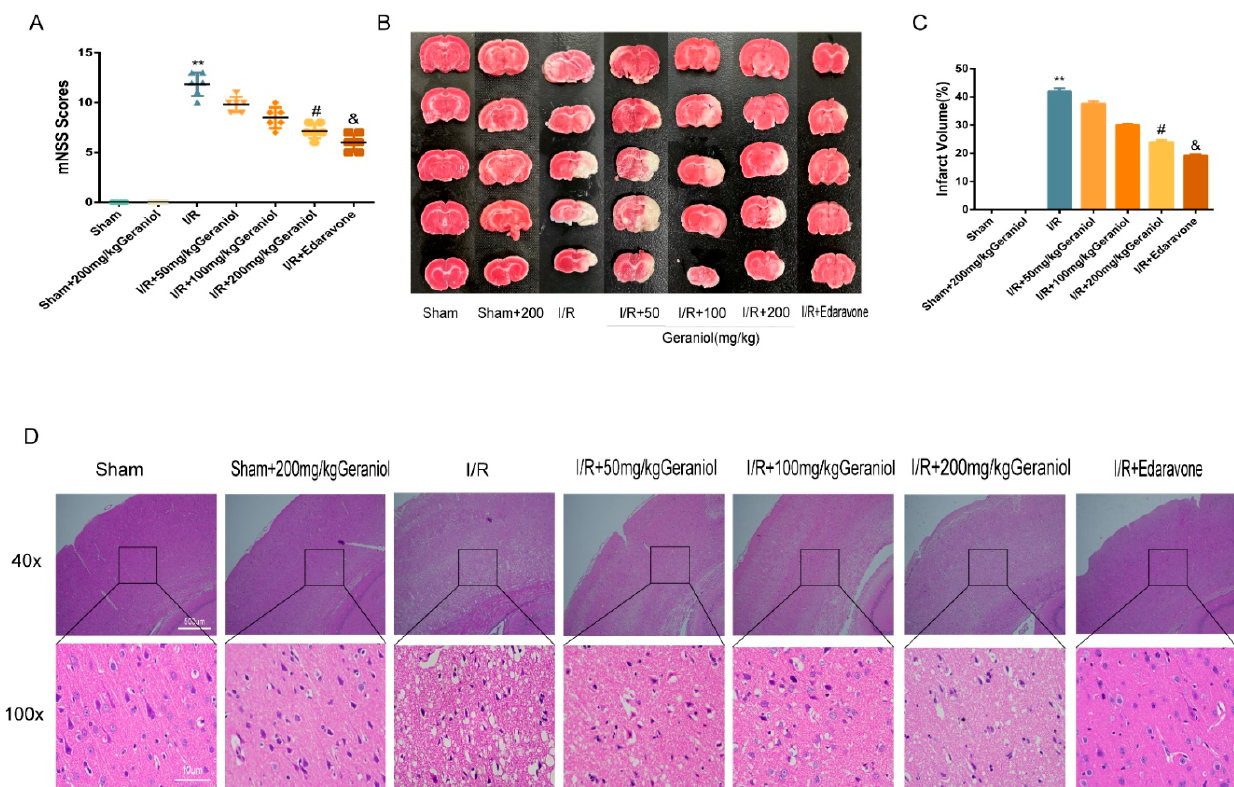
Figure 1. Protective effect of geraniol against ischemia–reperfusion (I/R)-induced brain damage. ( A ) Modified neuronal severity score (mNSS) of ischemic rats and score analysis ( n = 6). ( B , C ) Representative 2, 3, 5-triphenyl tetrazolium chloride staining images and statistical analysis of the brain infarct volume ( n = 3). ( D ) Representative hematoxylin-and-eosin-stained cerebral slices were imaged via microscopy. ** p < 0.01 I/R group vs. sham group, # p < 0.01 I/R + 200 mg/kg geraniol group vs. I/R group, & p < 0.01 I/R + edaravone group vs. I/R group.